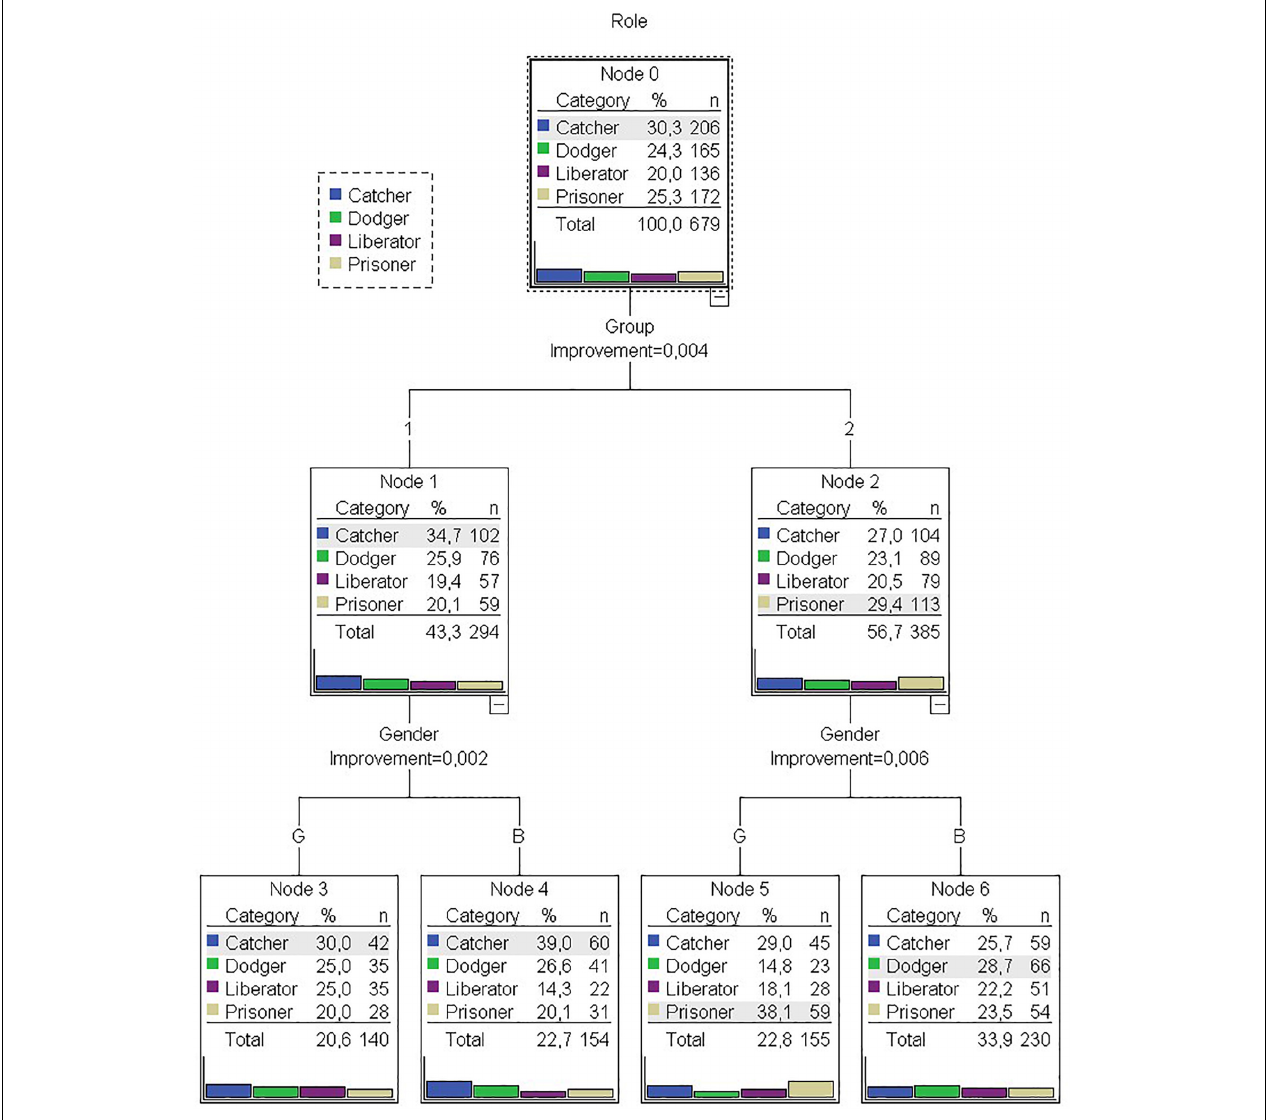
FIGURE 1 | Tree of predictive variables (IV): gender (girl “G” boy “B”), group (“1” “2”), taking into account the role (DV):